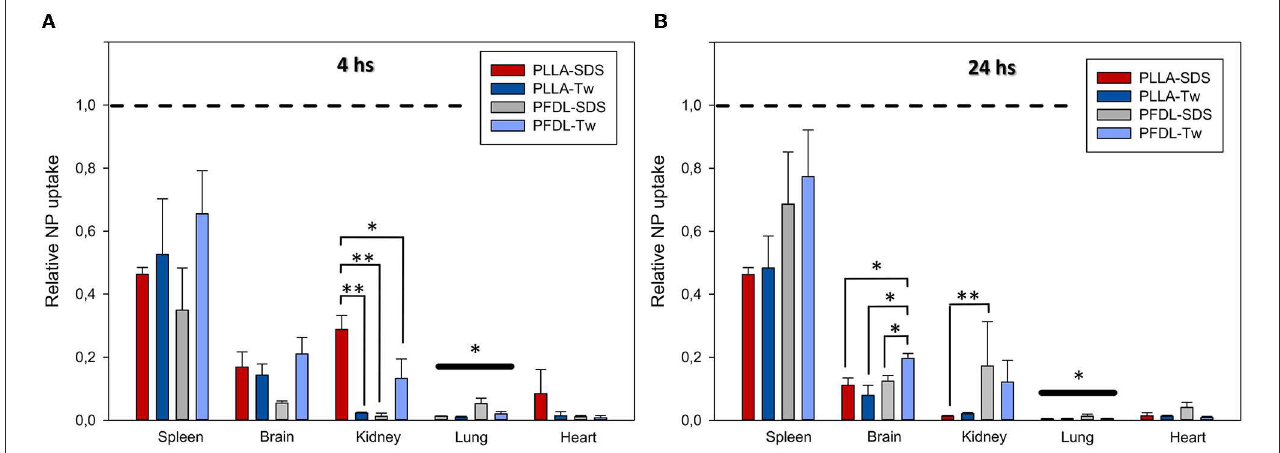
FIGURE6 Comparison of the relative NP uptake in the spleen, brain, kidney, lung and heart at 4 (A) and 24h (B) after intravenous injection. Given the differences in fluorescence dye intensity between NP types, the percentage of reactive fluorescent area values of each organ were normalized in relation to liver values (depicted at y = 1 with dotted lines) in order to enable a comparison between NP-types. The overall significantly lower relative NP uptake in the lung compared to other organs at both study points is depicted by bold significant level bars. Data were assessed using one-way ANOVA. Bars express means ± SEM. ** p < 0.01, * p <